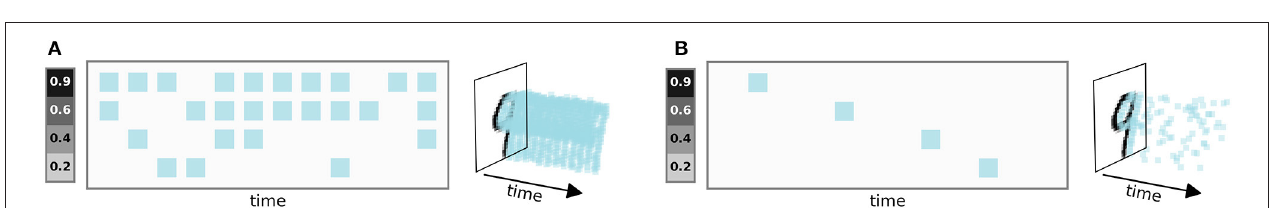
band-pass and composite characteristics according to different filter effects. The left of Figure 6C shows the spike output of the recurrent layer and its influence on the prediction result. All neurons have a positive effect (green) on the prediction results, except for neuron 11 marked by the black box. In addition, neurons 0, 10, and 15 make more contributions, revealing that the corresponding frequency features are more important for predicting this class. Figure 6D is the spike output of the hidden layer. The role of this layer is the feature mapping before prediction. All neurons also make a positive effect except for one neuron. The final prediction result ( Figure 6E ) is the spike sum of 5 output neurons and is normalized to probability. It can be seen that the SNN makes the correct prediction for a normal